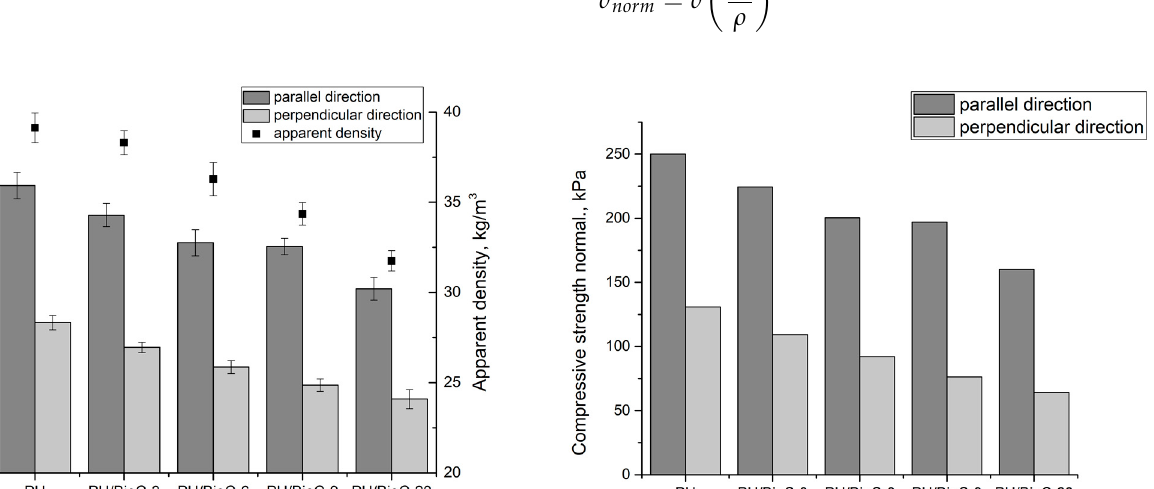
Table 4. Dimensional stability of polyurethane foams.